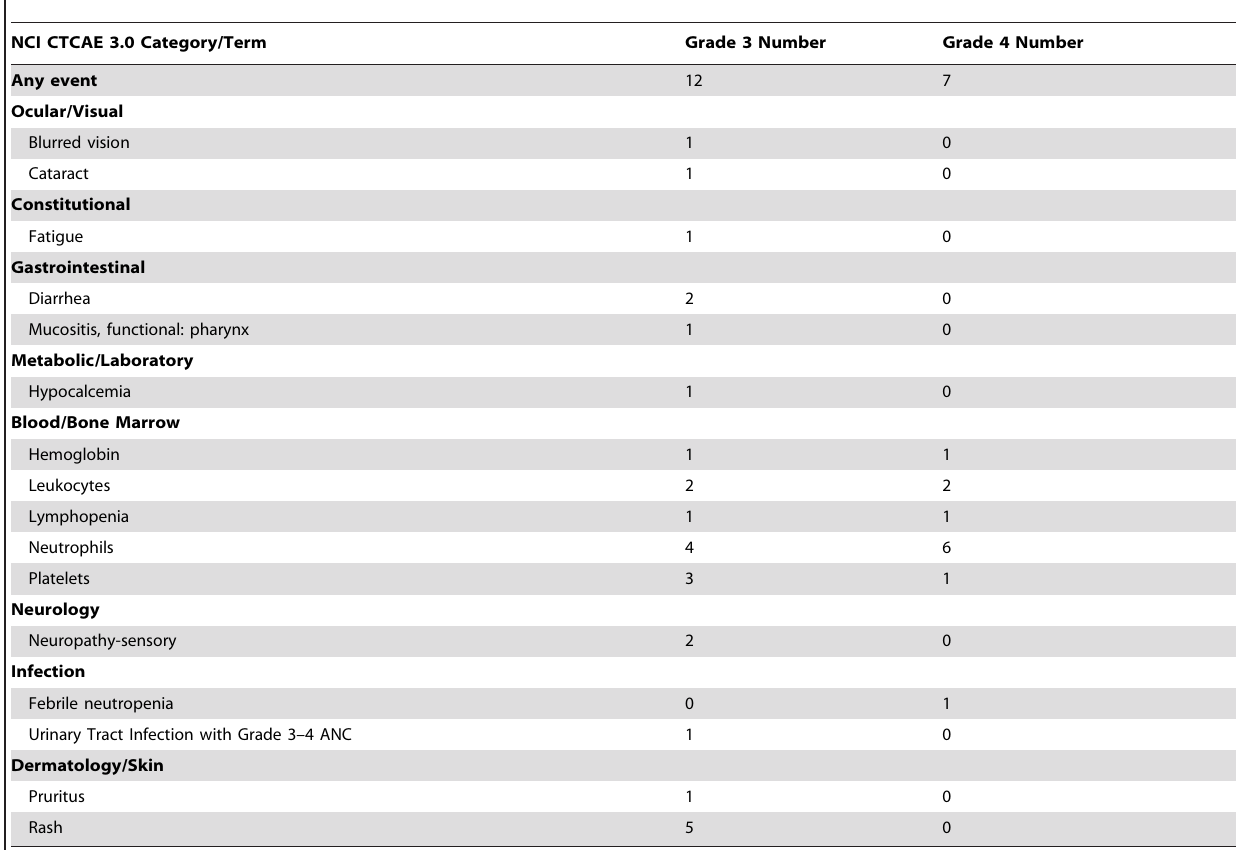
Table 2. Summary of Grade 3 or 4 Treatment-related Adverse